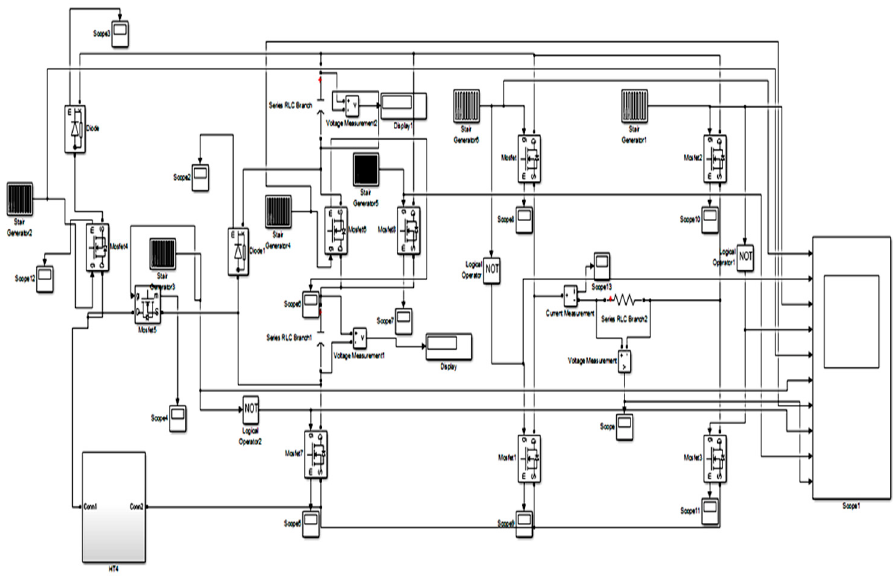
Figure 36. Simulation diagram of multilevel inverter interfaced with controlled chopper circuit.